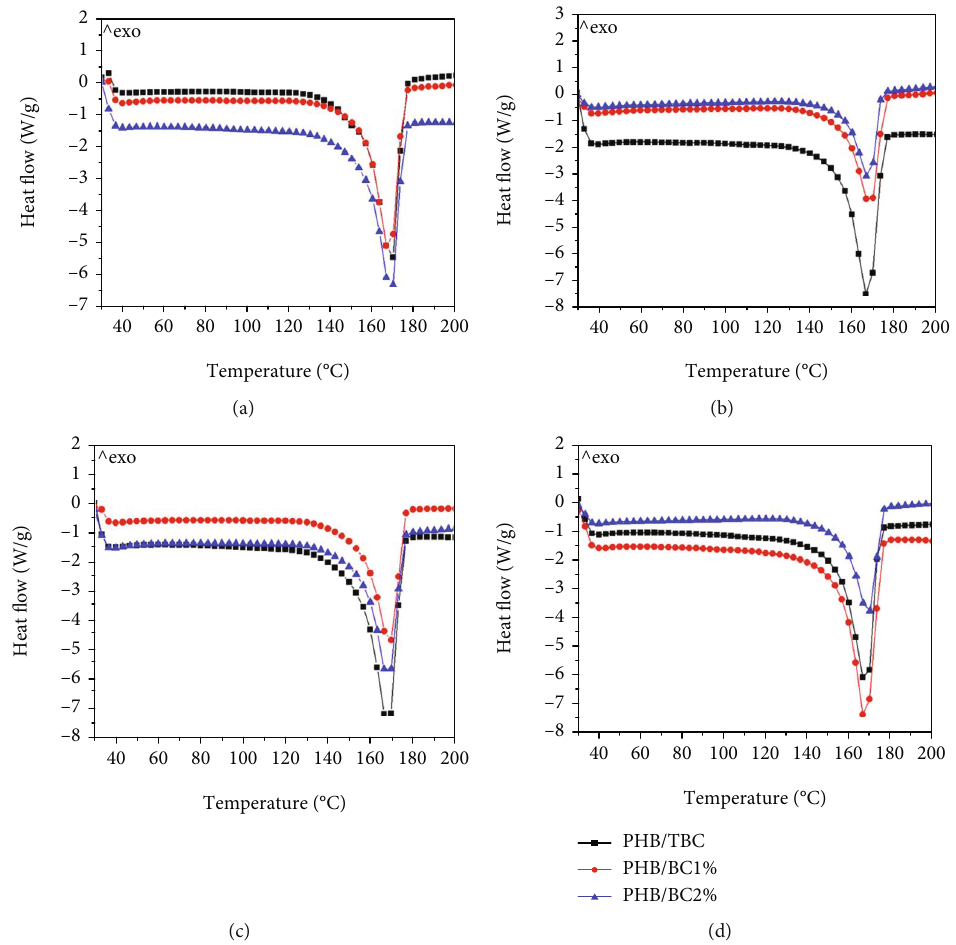
Figure 5: DSC thermograms for plasticized PHB sample and its biocomposites subjected in PBS medium at di ff erent time periods: (a) 5 days, (b) 10 days, (c) 15 days, and (d) 20